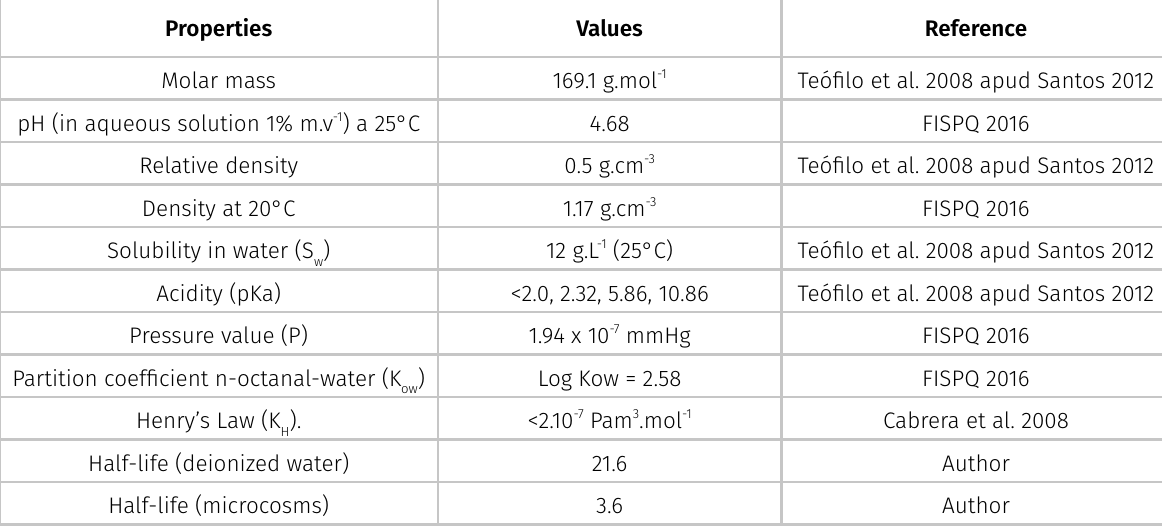
Table I. Physicochemical properties of Glyphosate